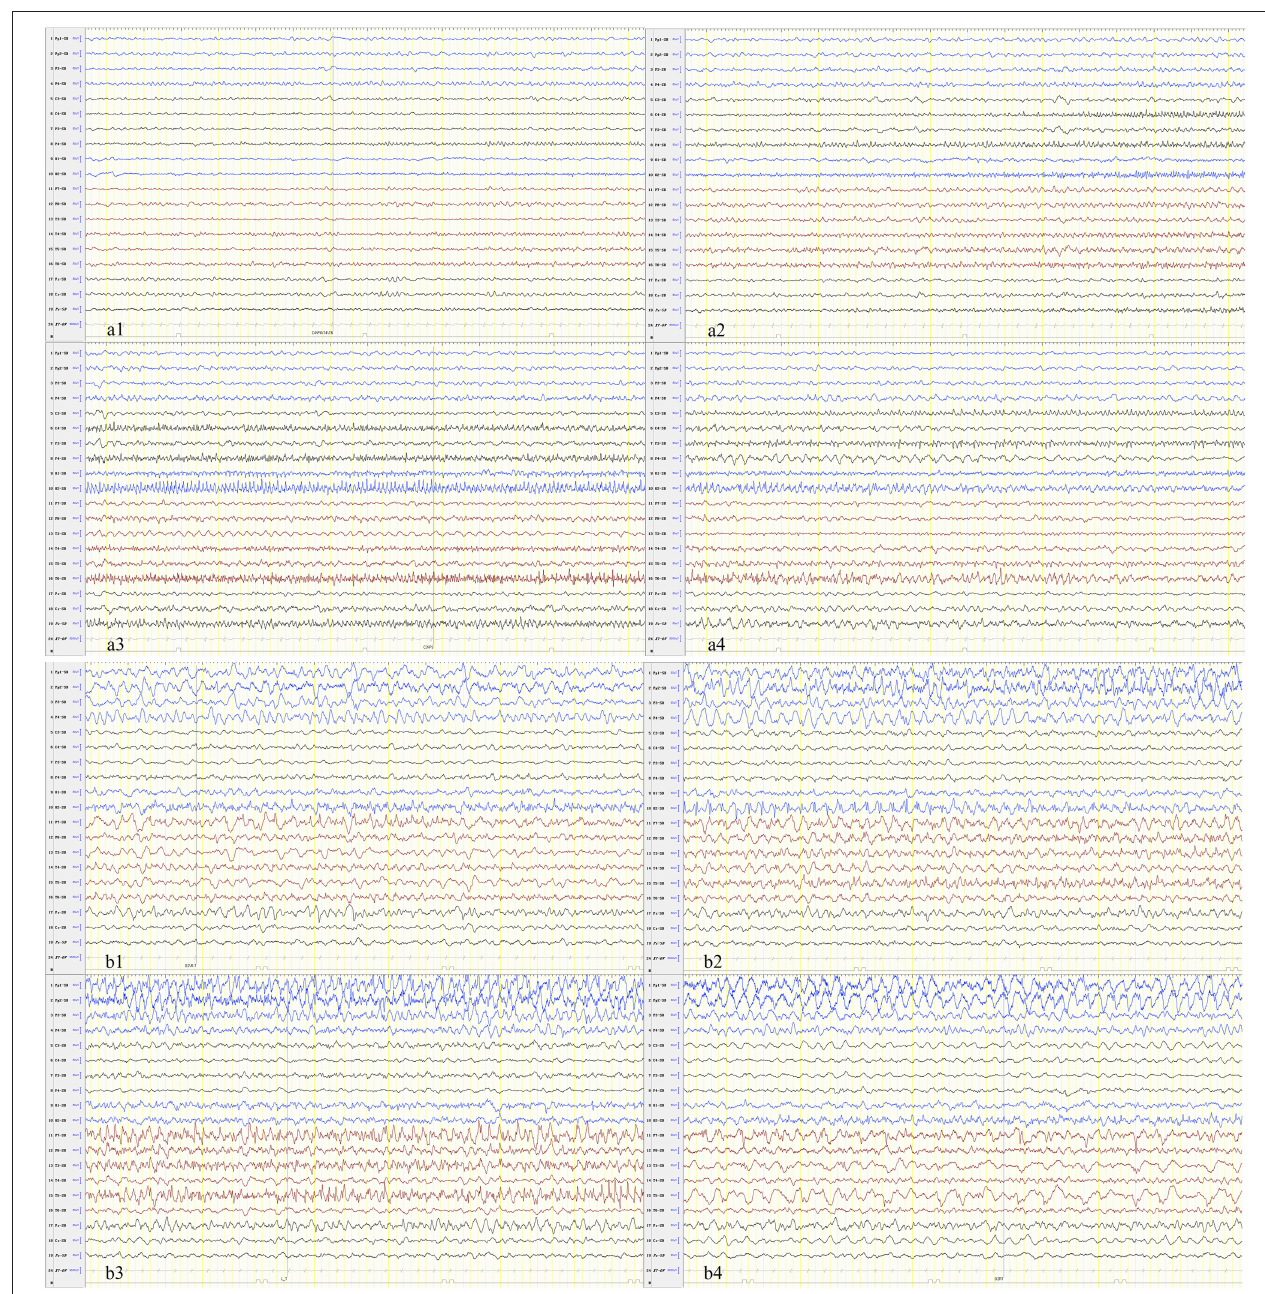
FIGURE 1 | The seizure begins in the focal or multifocal regions with spread to the unilateral or bilateral hemisphere and shifting from one hemisphere to the contralateral. (a) Patient 1 and (b) patient